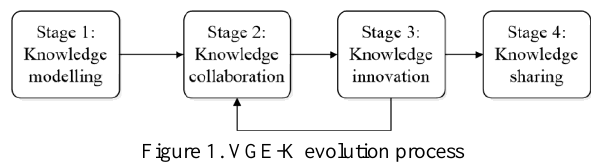
Figure 1. VGE-K evolution process